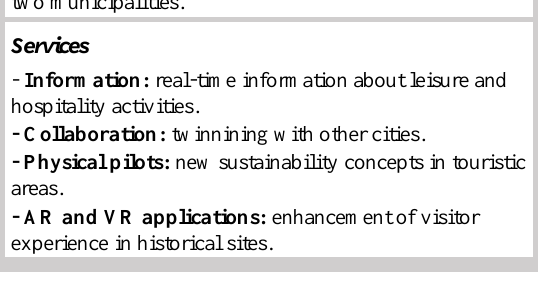
Figure 7. Digital Strategy Canvas for Tarragona (authors’ elaboration).